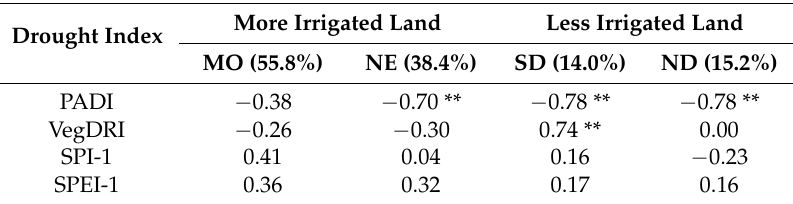
Table 4. Spearman’s rank correlation value between PADI, VegDRI, SPI-1, SPEI-1 and YAI in four Midwestern states. The percentage of irrigated area in each state was also provided. Two star superscript (**) indicates p < 0.01.